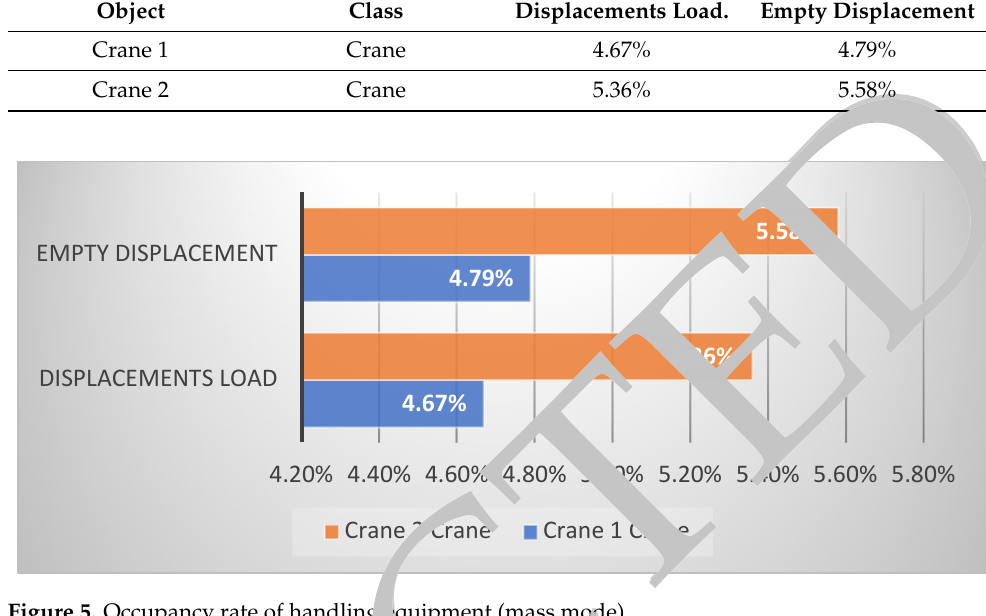
Figure 5. Occupancy rate of handling equipment (mass mode).